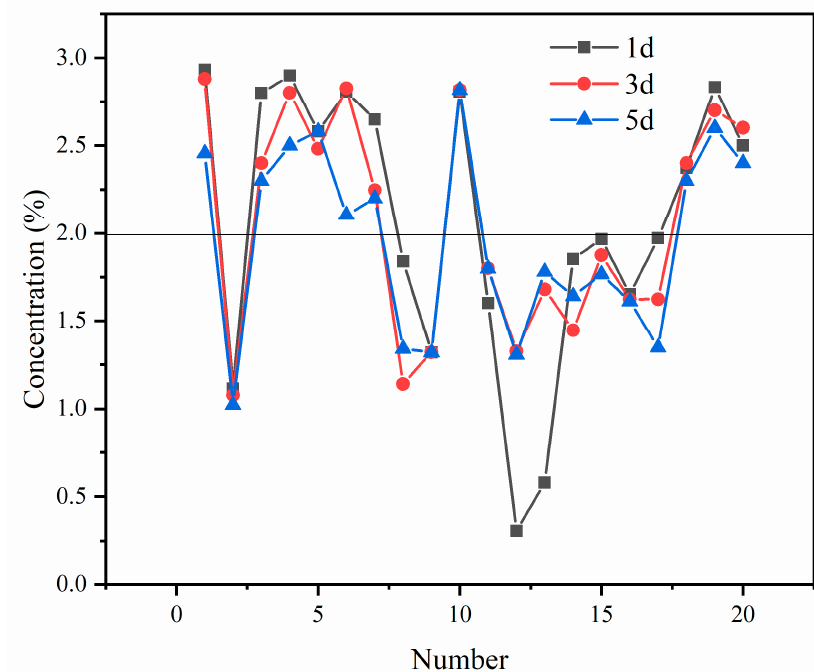
Figure 6. Variety of water-soluble salts.